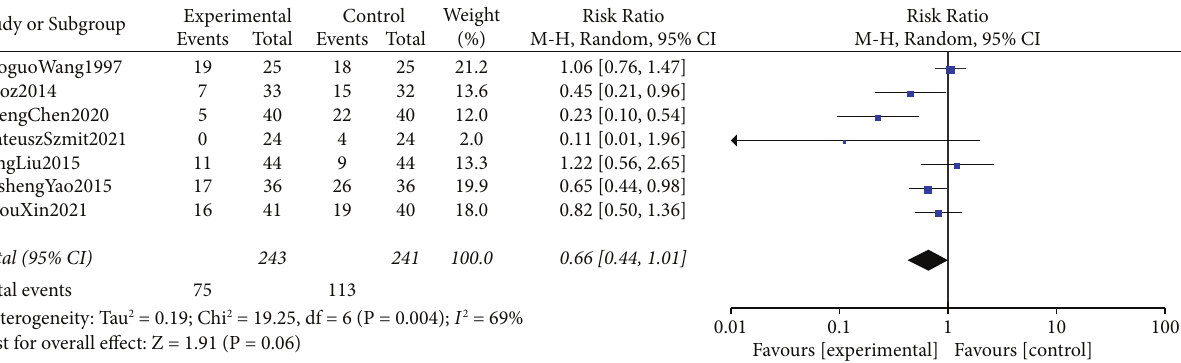
Test for overall effect: Z = 1.91 (P = 0.06) Favours [experimental] Favours [control] Figure 5: Forest plots comparing the incidence of postoperative nausea between the TEAS and control groups.